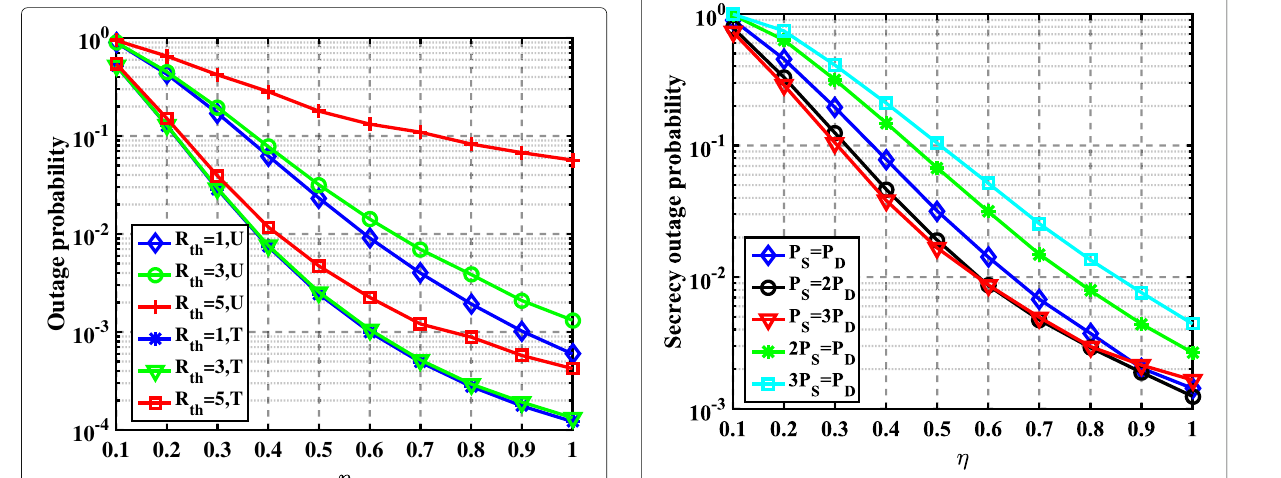
Fig. 7 Outage probability vs. η with various predetermined rate